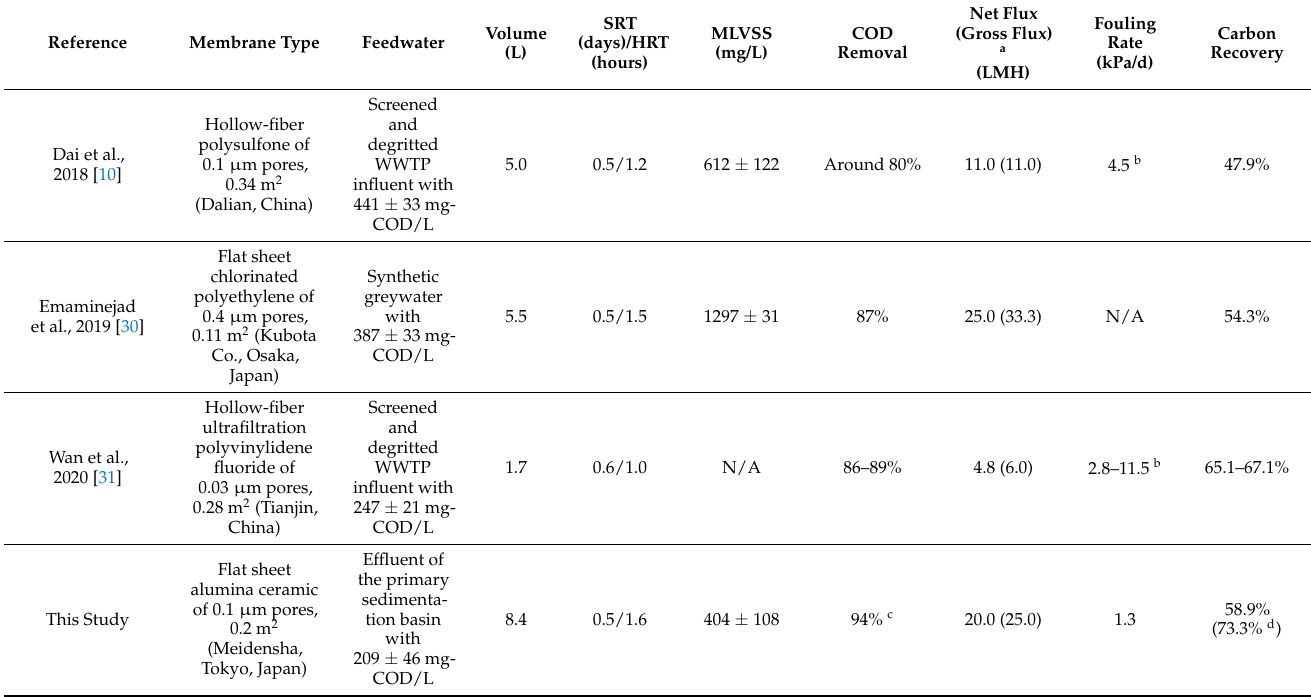
Table 1. Summary of the performances of HR-MBRs in recent studies.